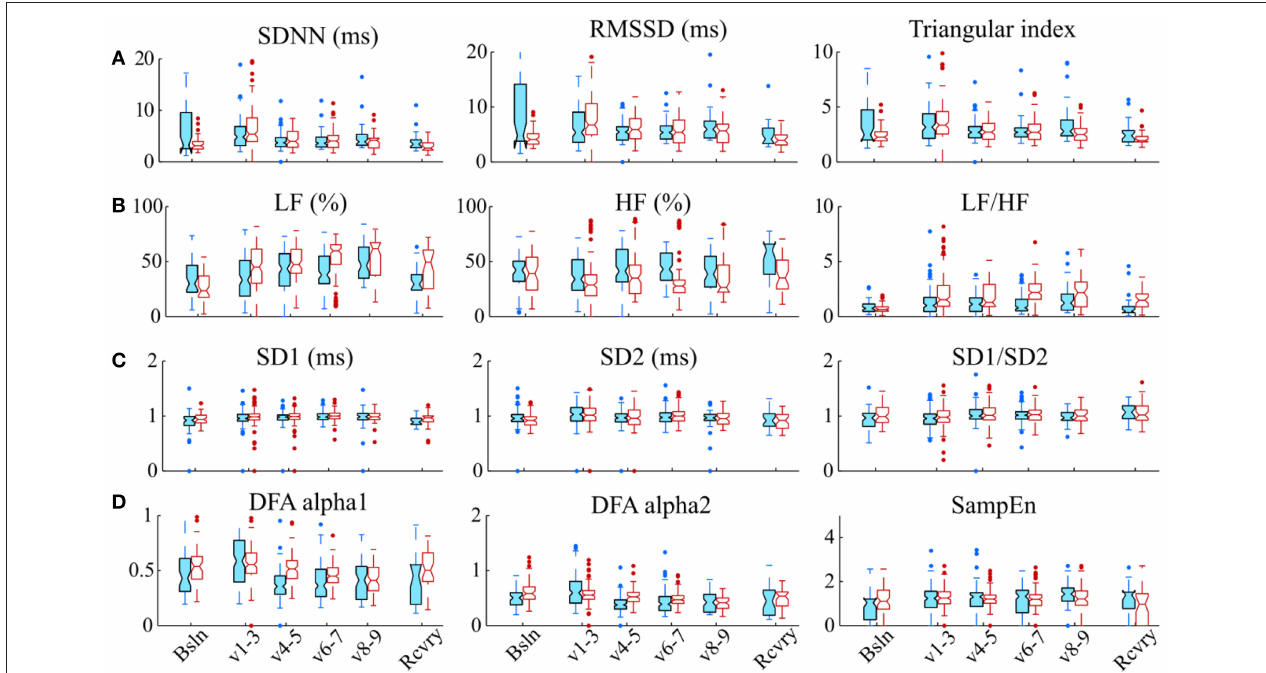
FIGURE 3 | Various HRV measurements do not distinguish modes of ventilation. (A) Time domain methods: standard deviation of RR intervals ( SDNN, ms), root mean square of the successive differences (RMSSD), and triangular index; (B) Frequency domain methods: relative power in low frequency band (LF, %); relative power in the high frequency band (HF, %), and the ratio of low-to-high-frequency power (LF/HF); (C) Analyses of Poincaré plots: the axis perpendicular to the line of identity (SD1), the axis on the line of identity SD2 and their ratio (SD1/SD2); and (D) Nonlinear methods: detrended fluctuation analysis (DFA), which has a short-term fractal exponent (alpha1) and a long-term fractal exponent (alpha2), and sample entropy (SampEn). These indices of HRV were measured during baseline (Bsln), ventilation (v1-3,1st h; V4-5, 2nd h; V6-7, 3rd h; & V8-9, 4th h) and recovery (Rcvry). These indices were not significantly different between BVV and CMV groups.